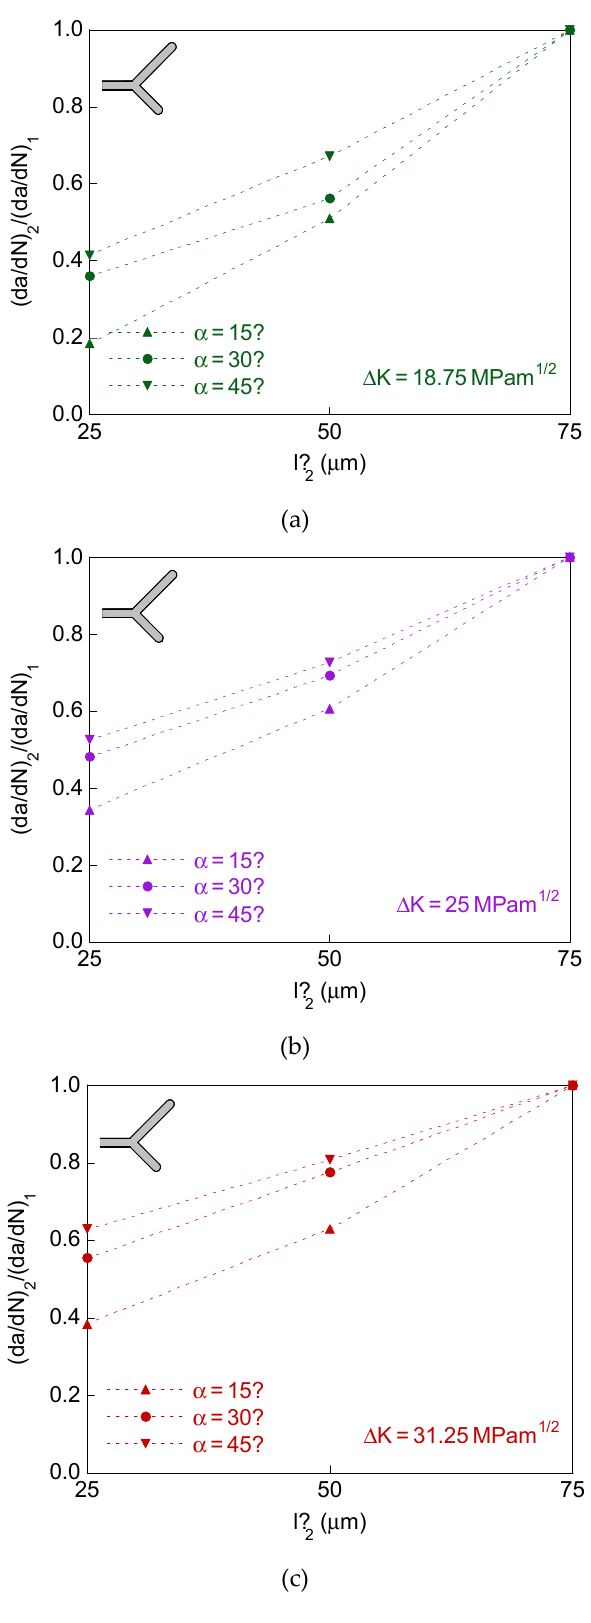
Figure 5. Crack tip growth rates ratio for different initial projected length and equal initial angle in the two branches: ( a ) Δ K = 18.75 MPam 1/2 ; ( b ) Δ K = 25 MPam 1/2 ; ( c ) Δ K = 31.25 MPam 1/2 .